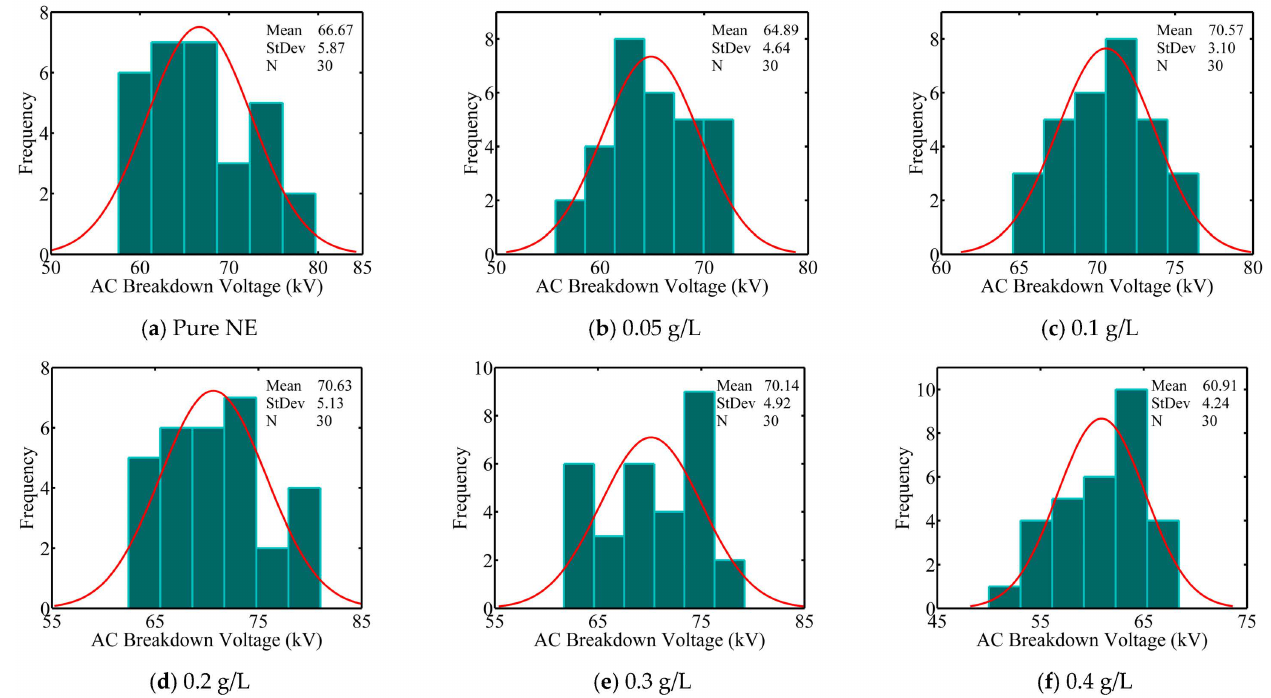
Figure 4. Histograms of NE and ZnO nanofluids for different